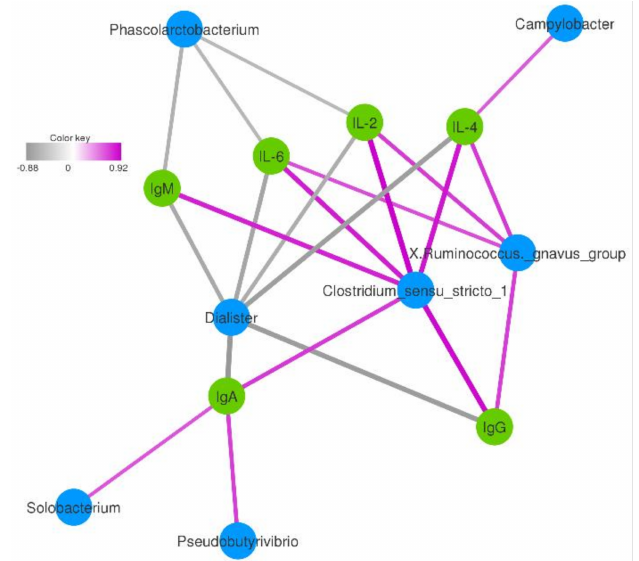
Figure 5. Correlation network showing the associations among lamb immunoglobulins, cytokines, and intestinal bacteria (relative abundance ≥ 0.1% in at least 60% of all samples). Only strong correlations (| R | ≥ 0.5 and p < 0.05) are displayed in the network. The edge width and the color (red: positive; grey: negative) are proportional to the correlation